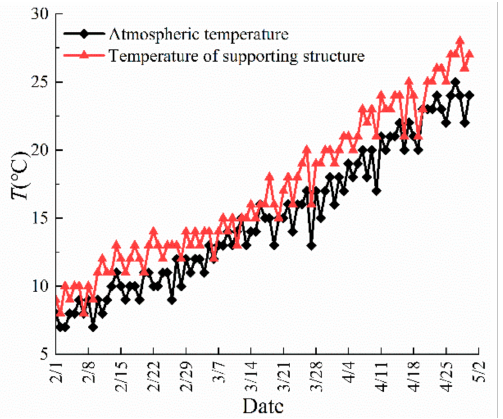
Figure 6. The variation of the temperature from February to April.